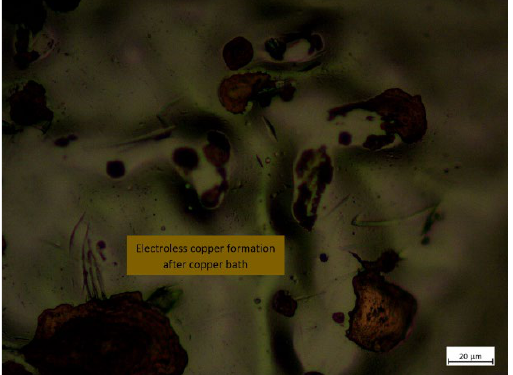
Figure 4. Copper formation during the electroless process on the PETG+MWCNT specimen in microscopic view.